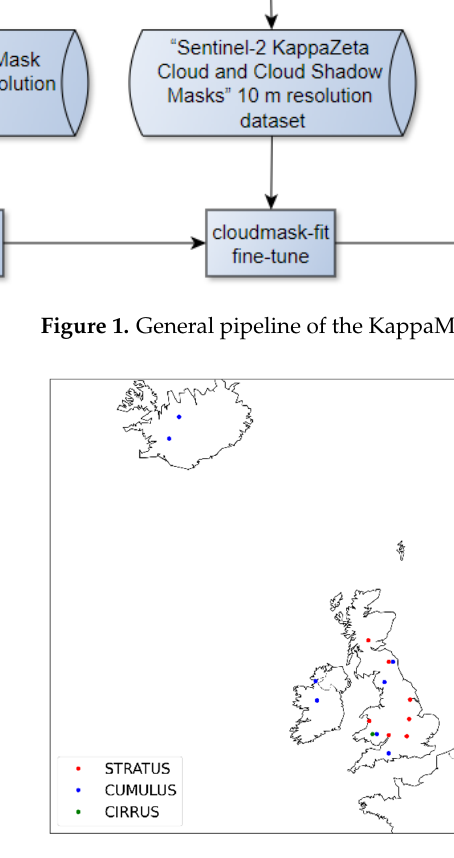
Figure 2. Sentinel-2 tiles used for labelling. Images with cumulus clouds are indicated as blue dots, images with stratus clouds are marked as red and images with cirrus clouds are marked as green. Each dot corresponds to one Sentinel-2 100 × 100 km data product. If the dots are exactly next to each other, it means the corresponding Sentinel-2 products are from the same location.